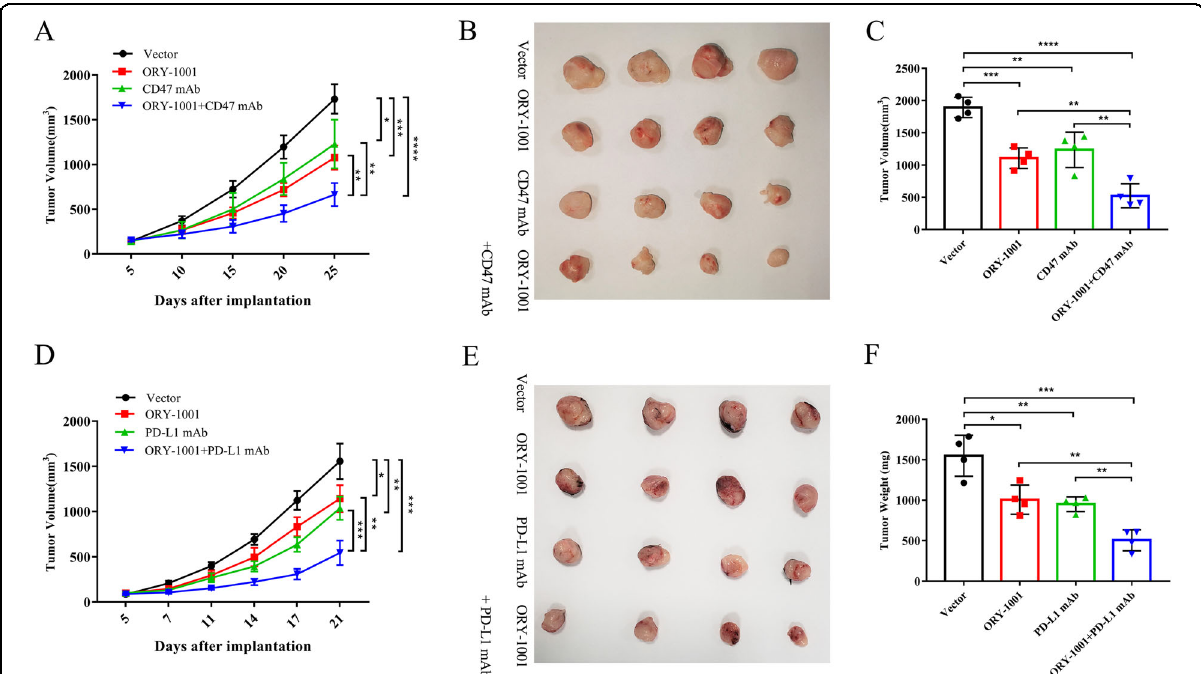
Fig. 6 LSD1 inhibitor enhances the ef fi cacy of anti-CD47/PD-L1 immunotherapy therapy in cervical cancer allograft model in vivo. A A combination of LSD1 inhibitors (50 mg/kg, three times a week) and anti-CD47 mAb (100 µg per mouse, three times a week) showed more signi fi cant inhibition of tumor growth than single drug administration ( n = 4 per group). Evaluation of the appearance ( B ) and weights ( C ) of tumors in the four groups demonstrated the enhanced ef fi cacy of anti-CD47 immunotherapy therapy when combined with an LSD1 inhibitor in vivo. D – F Enhanced treatment ef fi cacy was also achieved with a combined administration of LSD1 inhibitors (50 mg/kg, three times a week) and anti-PD-L1 mAb (300µg per mouse, three times a week) ( n = 4 per group). * p < 0.05, ** p < 0.01, *** p < 0.001, **** p <